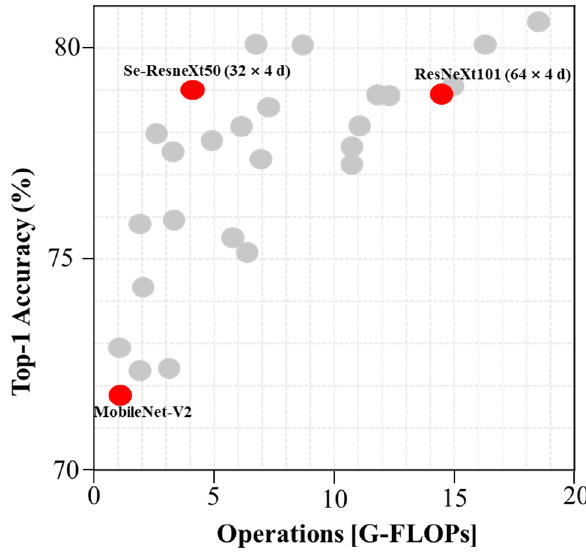
Figure 3. Results of the architecture used in the benchmarks.